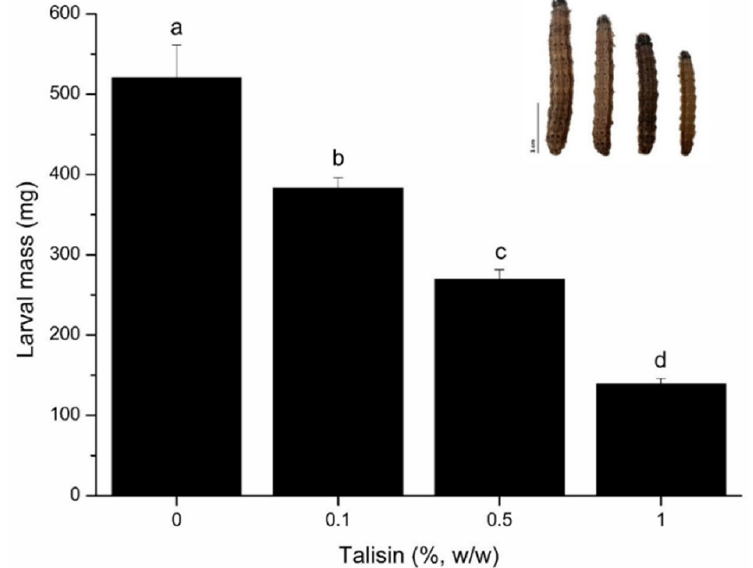
E ff ect of dietary Talisia esculenta reserve protein (talisin) on mass of fifth-instar Spodoptera frugiperda larvae. Inset: size di ff erence in a control larva (left) and a larva fed 0.1, 0.5 and 1% talisin (right). Di ff erent letters indicate significant di ff erences ( p < 0.05; Tukey’s test). Bar = 1